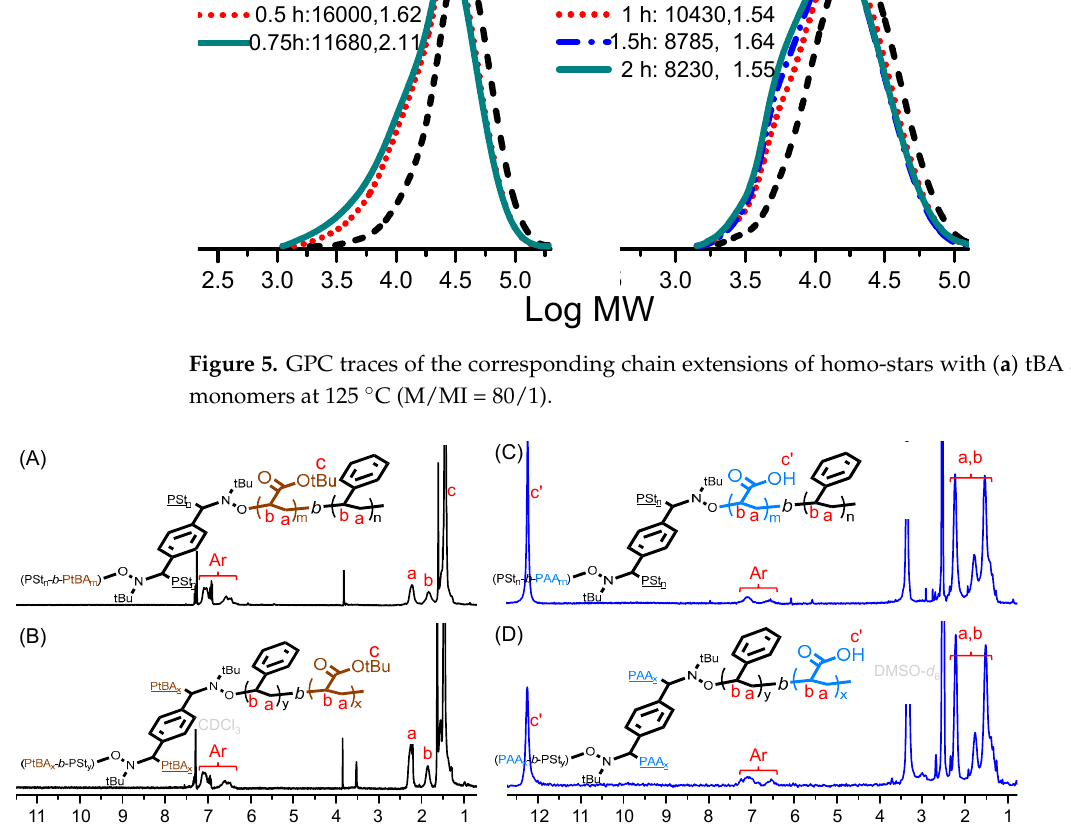
Figure 5. GPC traces of the corresponding chain extensions of homo-stars with ( a ) tBA and ( b ) St monomers at 125 °C (M/MI = 80/1).